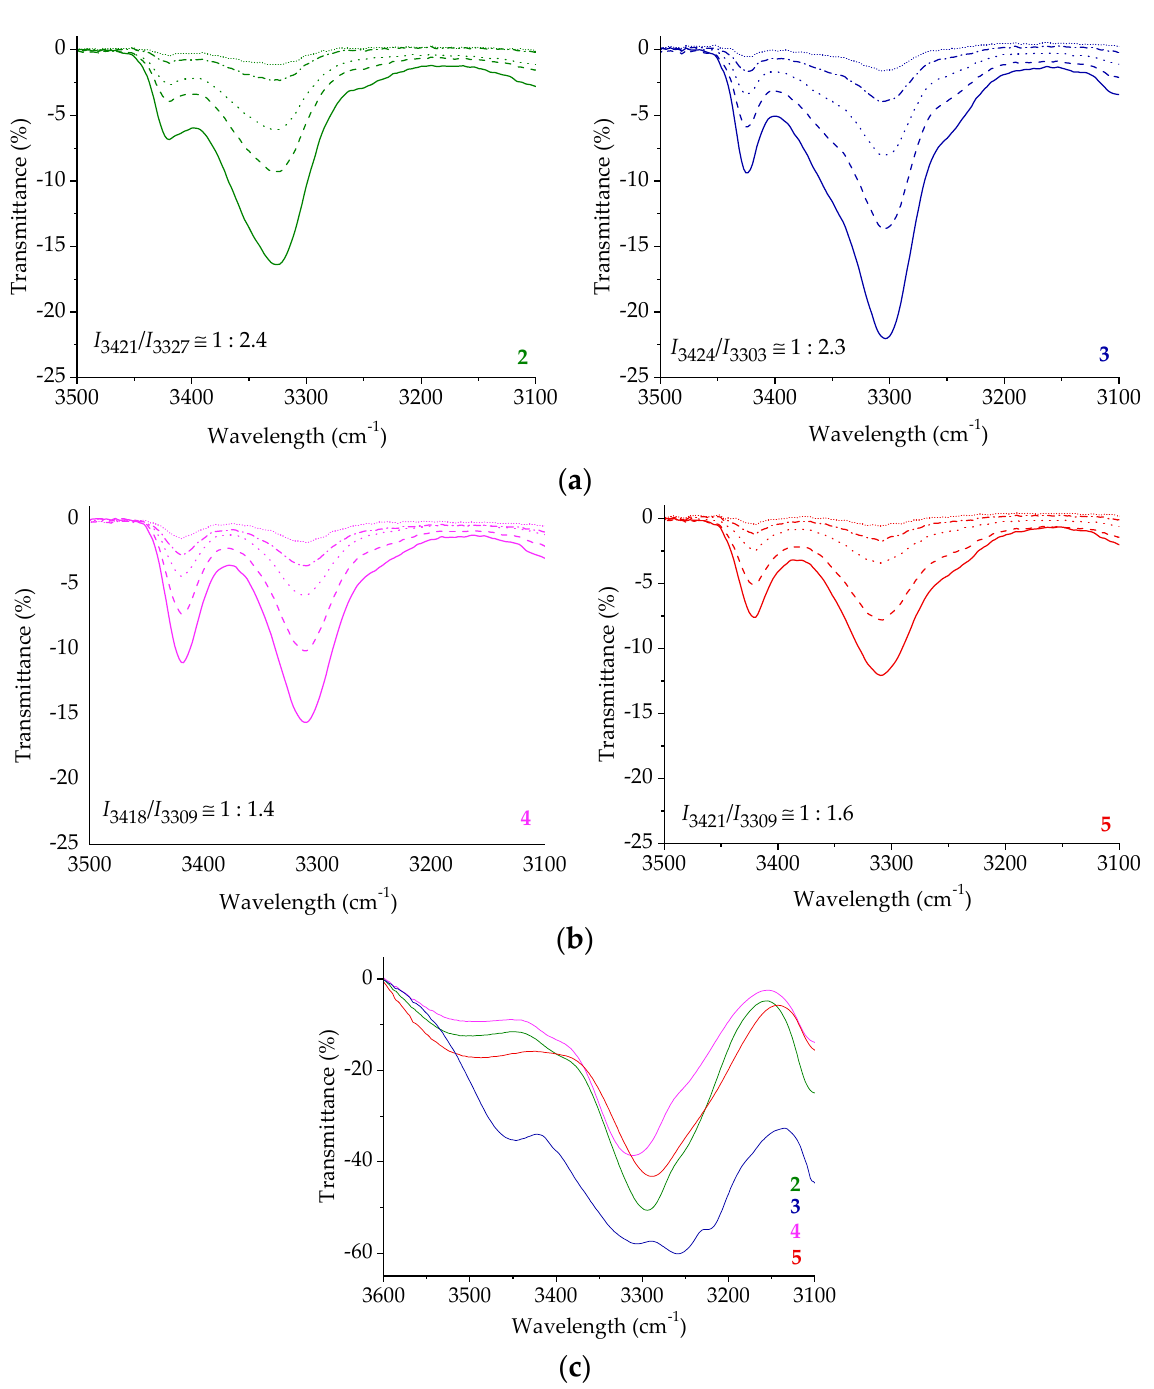
Figure 6. The NH stretching vibrations in concentration-dependent IR spectra of ( a ) hetero-( 2 , 3 ) and ( b ) homochiral peptides ( 4 , 5 ) in CH 2 Cl 2 ((—) c = 5 × 10 − 2 M, (——-) c = 2.5 × 10 − 2 M, ( · · · ) c = 1.25 × 10 − 2 M, (——-), c = 6.13 × 10 − 3 M, ( ····· ), c = 3 × 10 − 3 M) and ratios of free and associated NH bands, ( c ) the NH stretching vibrations of compounds 2 – 5 (2 mg) in KBr (200 mg).